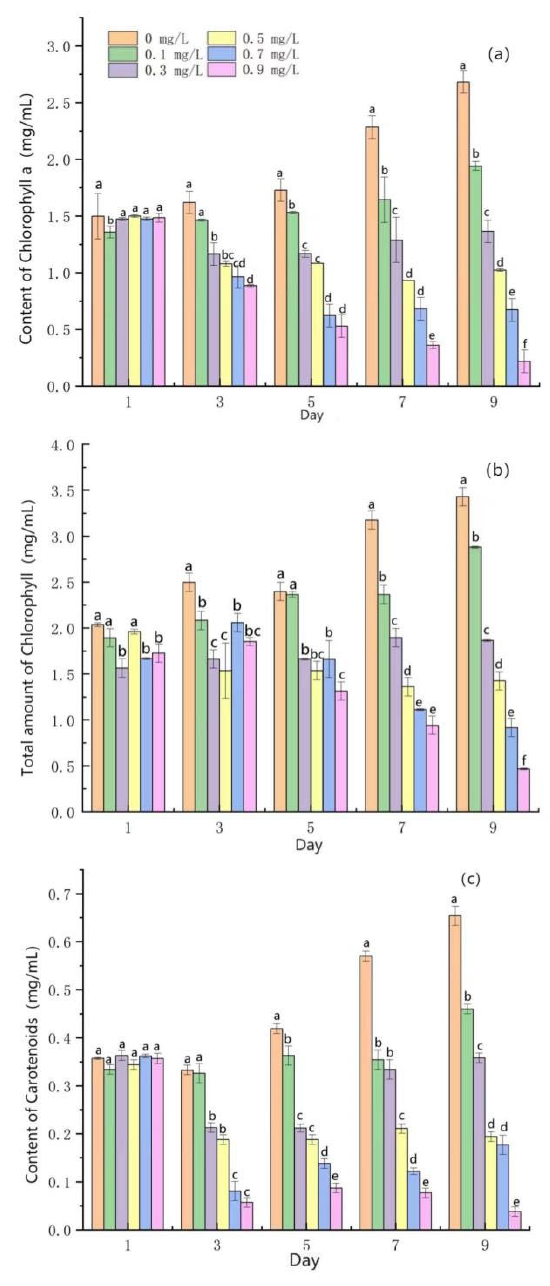
Figure 6. Effects of mercuric chloride concentration on the photosynthesis of Scenedesmus quadricauda: ( a ) content of Chl- a ; ( b ) content of total Chl.; ( c ) content of Car. (N = 3, the calculated value is the standard deviation).